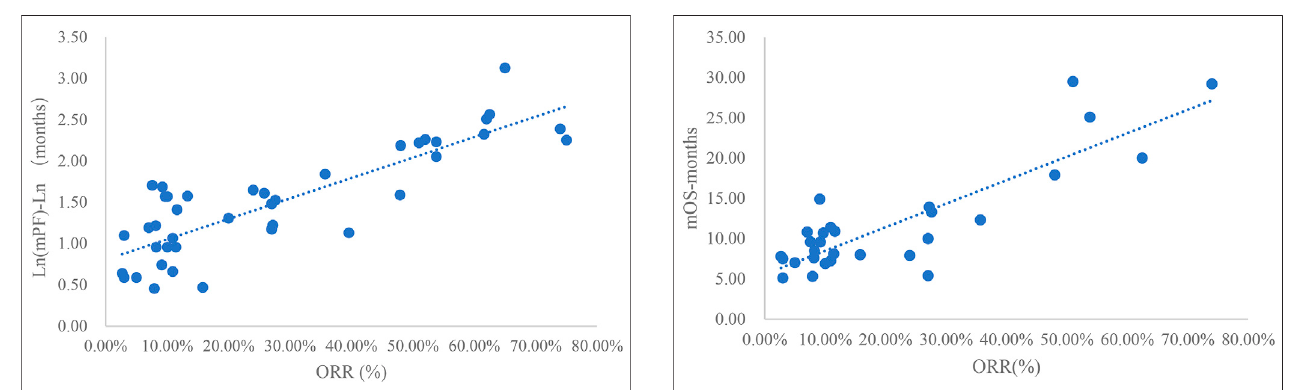
FIGURE 15 | Linear fi tting results for ORR and mOS. FIGURE 13 | Linear fi tting results for ORR and ln